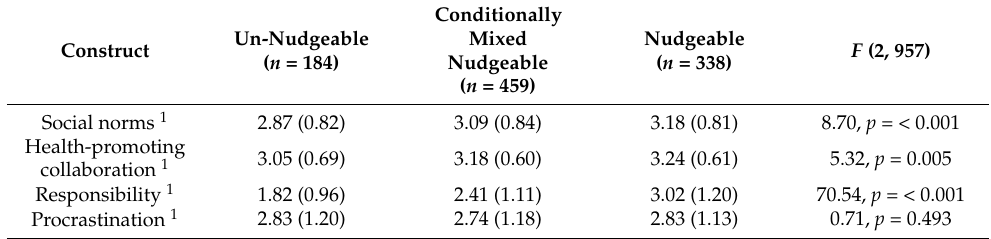
Table 7. Descriptive statistics for the three clusters, as well as F -values comparing these